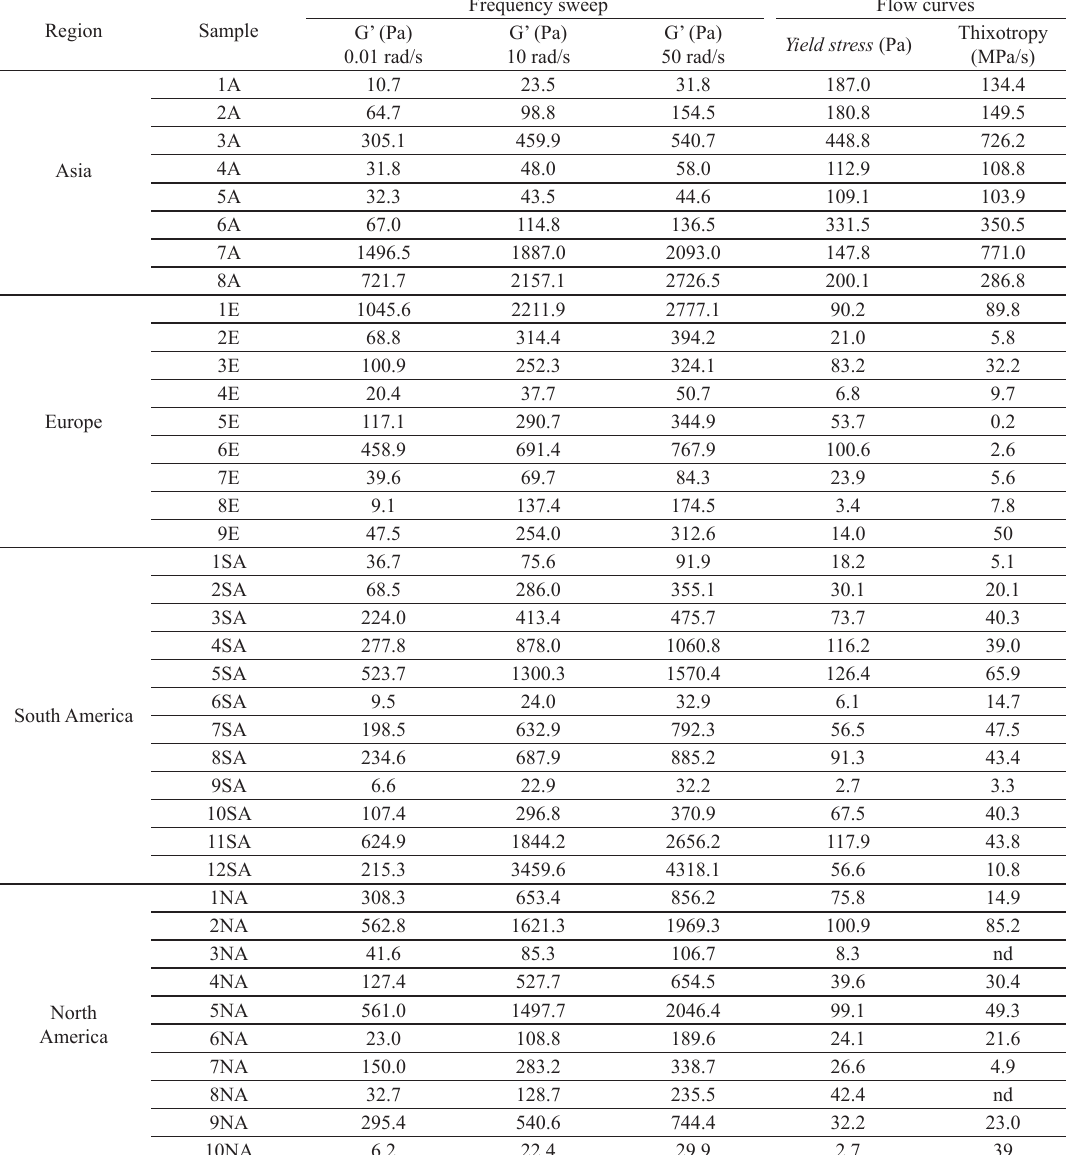
Table 3. Rheological parameters (G’, yield stress and thixotropy) of the emulsions. Region